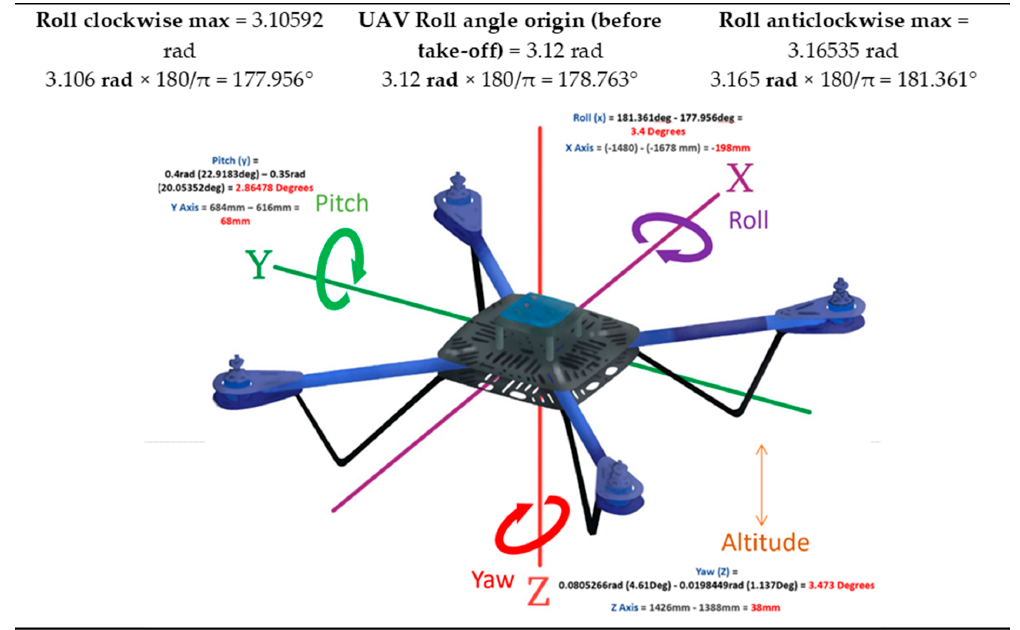
Figure 23. Manual full flight envelope whilst capturing 6 s worth of data. The movement is significant and has a direct effect on the NDT data captured using a thermal camera [26].